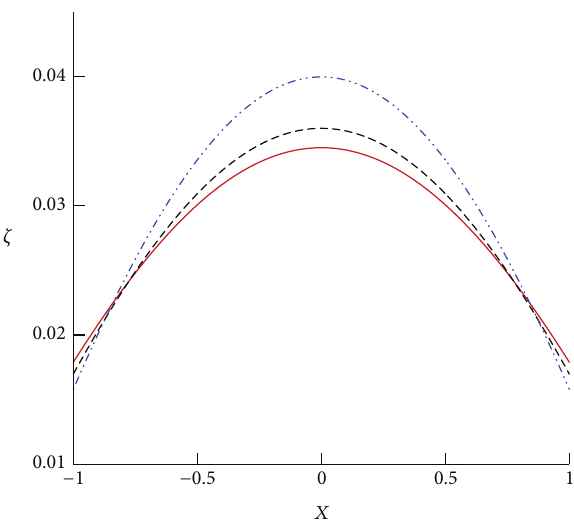
Figure 7: Variation of the plate deflection 𝜁(𝑋) near the crest versus 𝑋 for different plate thicknesses 𝑑 . Solid line: 𝑑 = 0.001 ; dashed line: 𝑑 = 0.005 ; dash-dot-dotted line: 𝑑 = 0.01 .